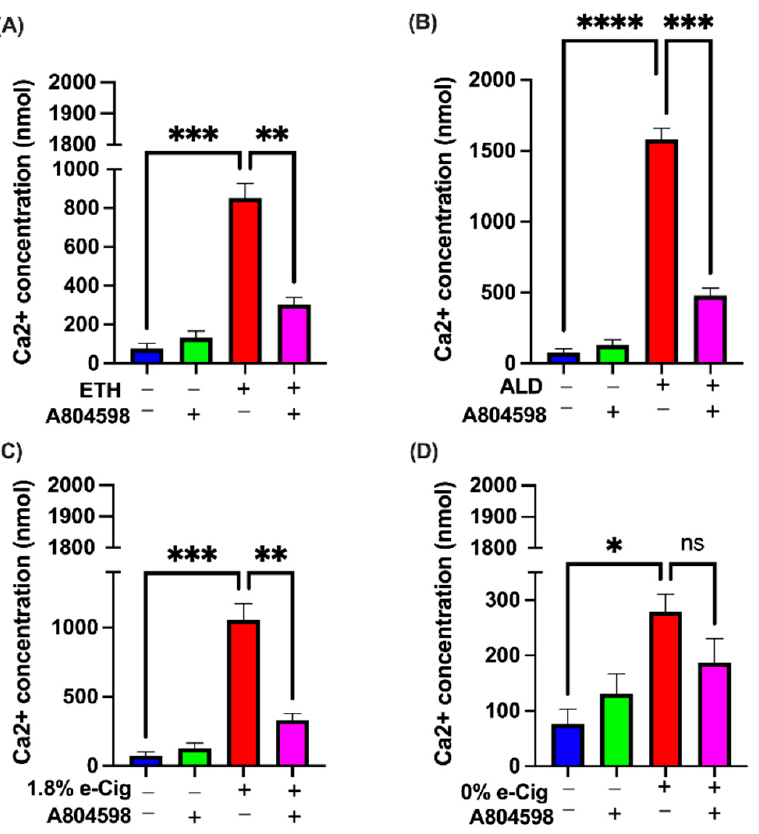
Figure 3. By blocking P2X7r and TRPV1 channels, A804598 inhibited the intracellular Ca 2+ influx enhanced by ETH, ALD, or 1.8% e-Cig . hBMVECs exposed to ( A ) ETH, ( B ) ALD, and ( C ) 1.8% e-Cig showed one thousand-to-fifteen-hundred-fold increase in intracellular Ca 2+ levels and cells treated with A804598 significantly diminished the intracellular Ca 2+ levels. ( D ) e-Cig with 0% nicotine showed no impact on intracellular Ca 2+ levels ( n = 3). One-way ANOVA was used for the statistical analyses as * p ≤ 0.05, ** p ≤ 0.01, *** p ≤ 0.001, **** p ≤ 0.0001 and ns (not significant). 3.5. P2X7r Inhibition Protected the Mitochondrial Function and Prevented Upregulation of Pro-Apoptotic Factors in Response to ETH, ALD, and 1.8% e-Cig Exposure In response to various stimuli, surplus of Ca 2+ in ER lumen opens additional ‘open Ca 2+ channels’ between ER and the mitochondrial outer membrane increasing Ca 2+ release into the mitochondrial matrix [37]. In such a scenario, expression of voltage-dependent anion channel (VDAC) is known to increase, as VDAC is a major component of the ‘open Ca 2+ channels’ [38]. Proteins isolated from hBMVECs exposed to ETH, ALD, and 1.8% e-Cig showed increased VDAC expression (Figure 5A). Modest increase of Ca 2+ in mitochondrial matrix is known to stimulate oxidative phosphorylation, but beyond a critical threshold the mitochondrial matrix calcium (Ca 2+ m ) transmits and amplifies apoptotic signals [39]. Western blots of mitochondrial fractions revealed mitochondrial translocation of BAX protein leading to the loss of mitochondrial outer membrane, and damage to mitochondrial membrane potential (MMP) (Figure 5B). Compromised mitochondrial membranes result in the cytosolic release of pro-apoptotic transcription factor, namely apoptosis inducing factor-1 (AIF1), and cytochrome C (Figure 5C). hBMVECs treated with A804598 (A80) presented a reduced BAX activation, retained the MMP and foiled the cytosolic release of apoptotic inducing factor-1 (AIF1), and cytochrome C